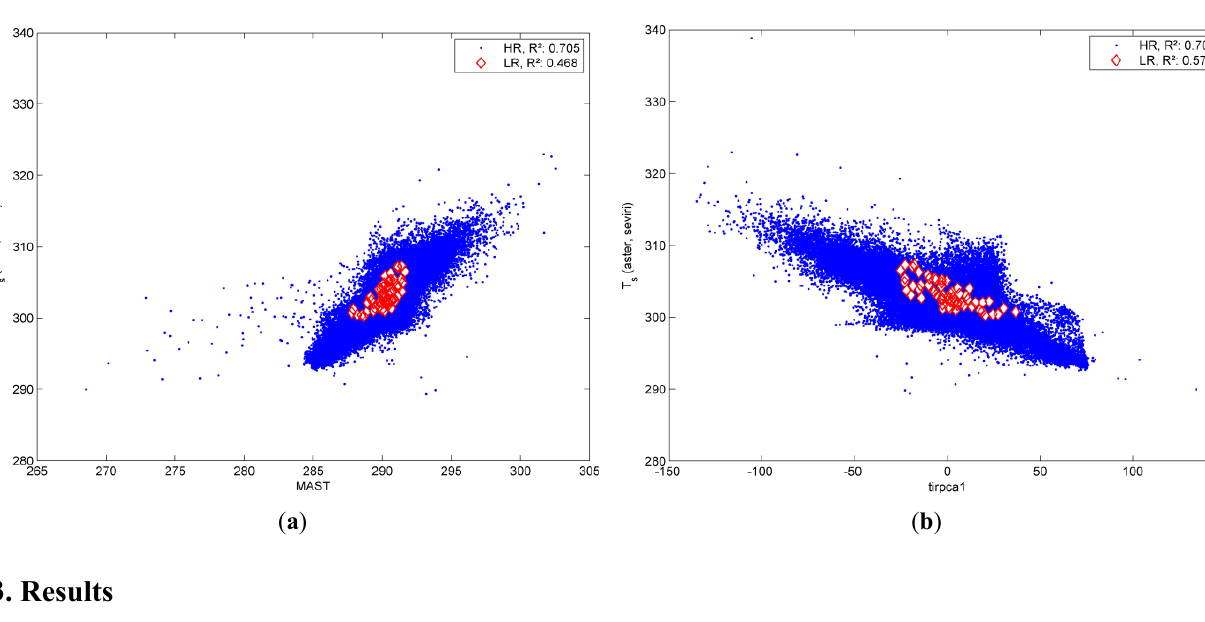
Figure 1. Relation between dependent variable land surface temperature (LST) in high spatial resolution (HR) (blue) and low spatial resolution (LR) (red) domain and different predictors. ( a ) mean annual surface temperature (MAST) ( b ) first principal component of thermal infrared (TIR)